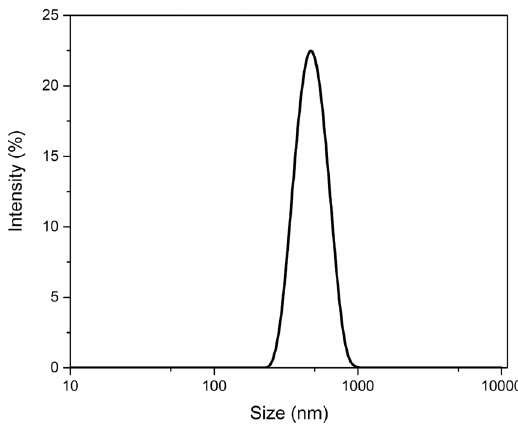
Figure 14: Particle size distribution curve of BSA/AM microcapsules.